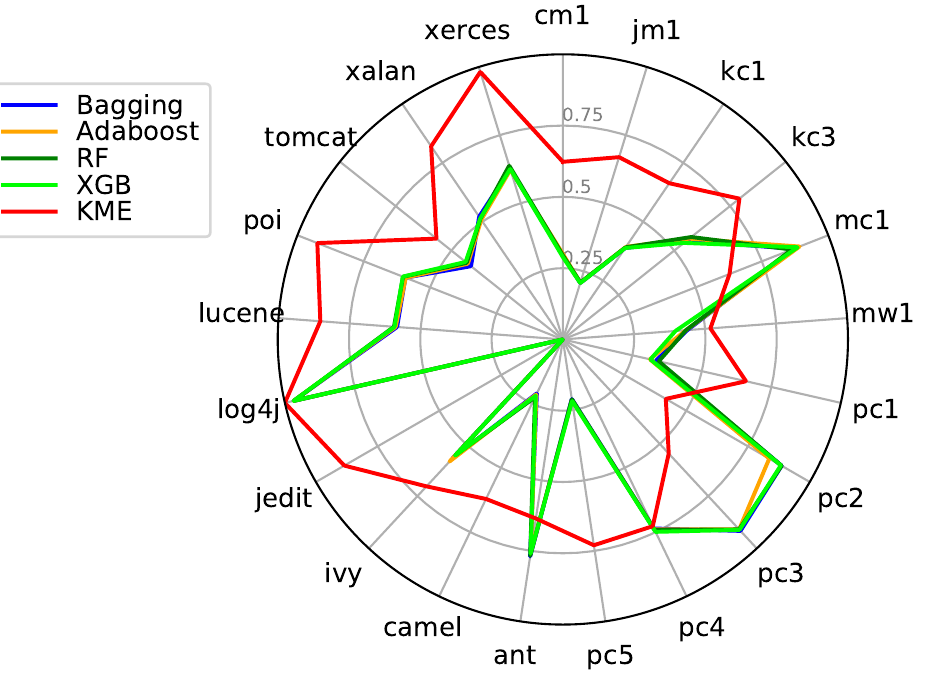
Figure 8. Precision for the ensemble classifiers and KME.